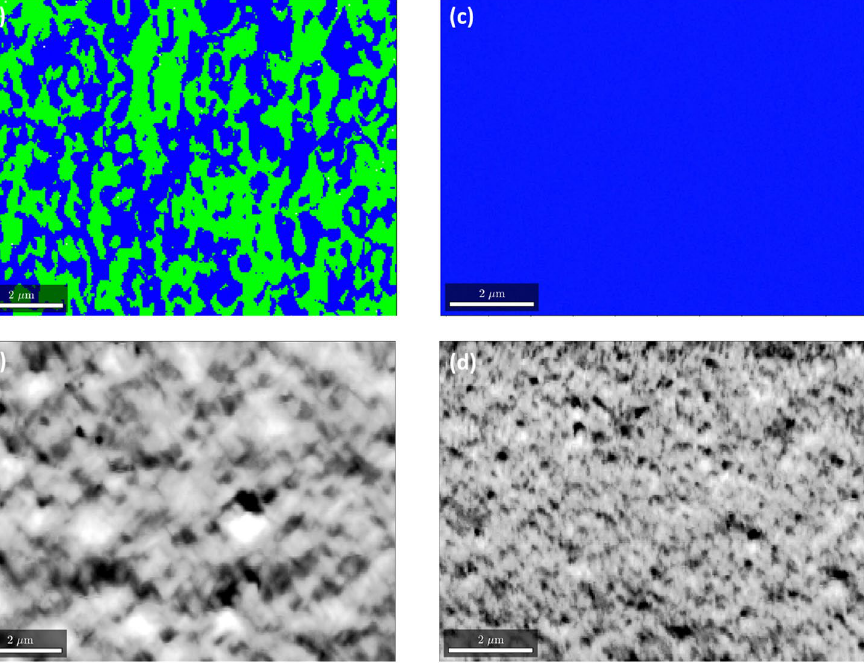
Figure 5. EBSD Inverse Pole Figure (IPF) maps of GaP thin films. ( a ) Grown on a different (001) Si substrate with similar growth conditions as the sample shown in Fig. 4.(b) corresponding BSE image derived from the EBSD patterns ( c ) IPF-map of GaP grown on a 4° misoriented Si substrate, not showing any APDs and ( d ) its corresponding BSE image derived from the EBSD patterns. The colour keys for the IPF-maps in ( a ) and ( c ) are the same as shown in Fig.